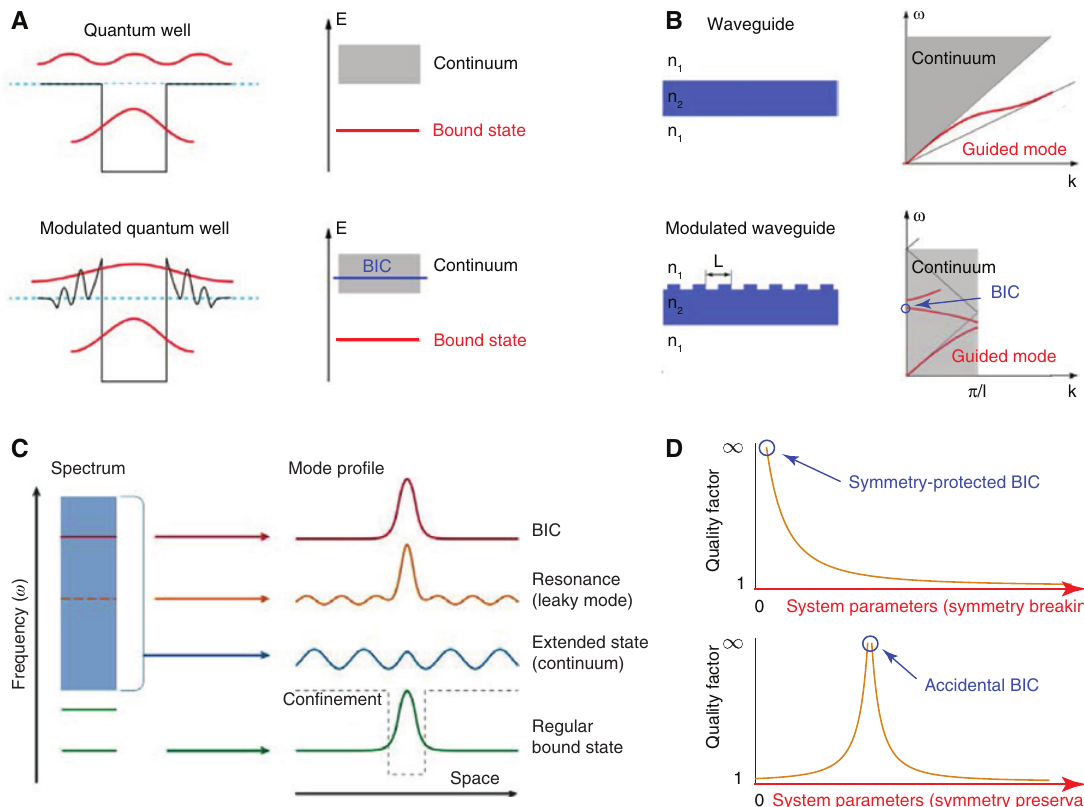
Figure 2: Concept of bound states in the continuum. (A) Schematic illustration of origin of BICs in quantum mechanical systems. Modulation of the potential of a conventional quantum well (top panel) with spatially unbound oscillations (lower panel) allows for localization of a bound state within the continuous spectral range (BIC, shown in blue). (B) Schematic illustration of origin of BICs in photonic systems. Here, emergence of a BIC (shown in blue) within the continuous spectral range is due to modulation of the dielectric function of a regular waveguide (top panel) with a periodic perturbation (lower panel). (C) Different families of states sustained in an open photonic system, and their position in the spectrum: regular bound states, extended radiation continuum modes, leaky resonances and BICs. (D) Different mechanisms of BIC formation: due to symmetry protection (upper panel) and parameter tuning (lower panel). A symmetry-protected BIC transforms into a leaky resonance with a finite Q factor when the symmetry is broken. An accidental BIC emerges via continuous tuning of the system parameters, which preserve the structural symmetries. Part (C) is adapted with permission from